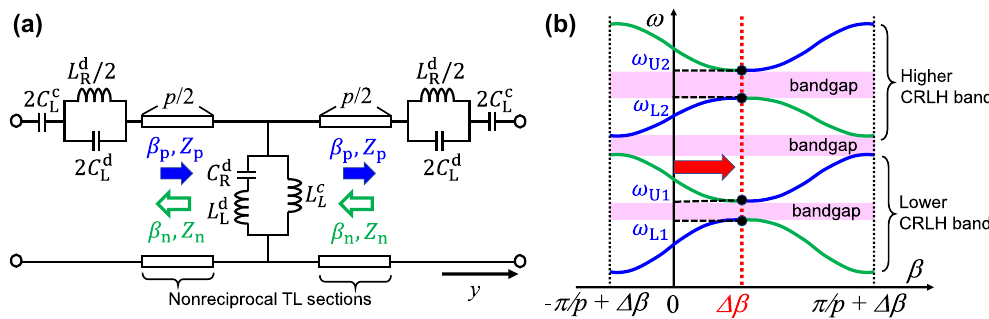
Figure 3: An equivalent circuit model and dispersion diagram for the nonreciprocal dual-band CRLH metamaterial lines. (a) The equivalent circuit model for the unit cell. (b) Typical dispersion curves without any Dirac